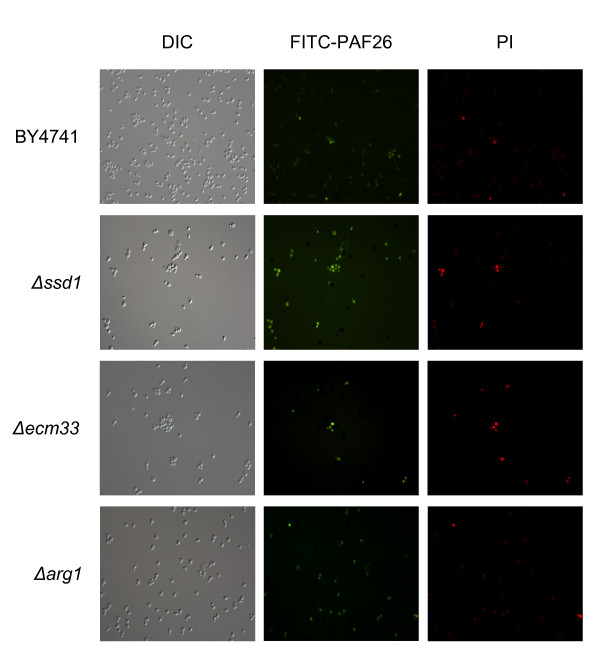
Differential interaction of S. cerevisiae deletion mutants with FITC-PAF26. Representative fluorescence micrographs of the parental BY4741 and S. cerevisiae deletion strains Δssd1, Δecm33, and Δarg1, as indicated at the left. Optical and image acquisition settings were the same for each fluorophore and thus differences in fluorescence intensity among strains reflect real differences. Others details as in Figure 6B.